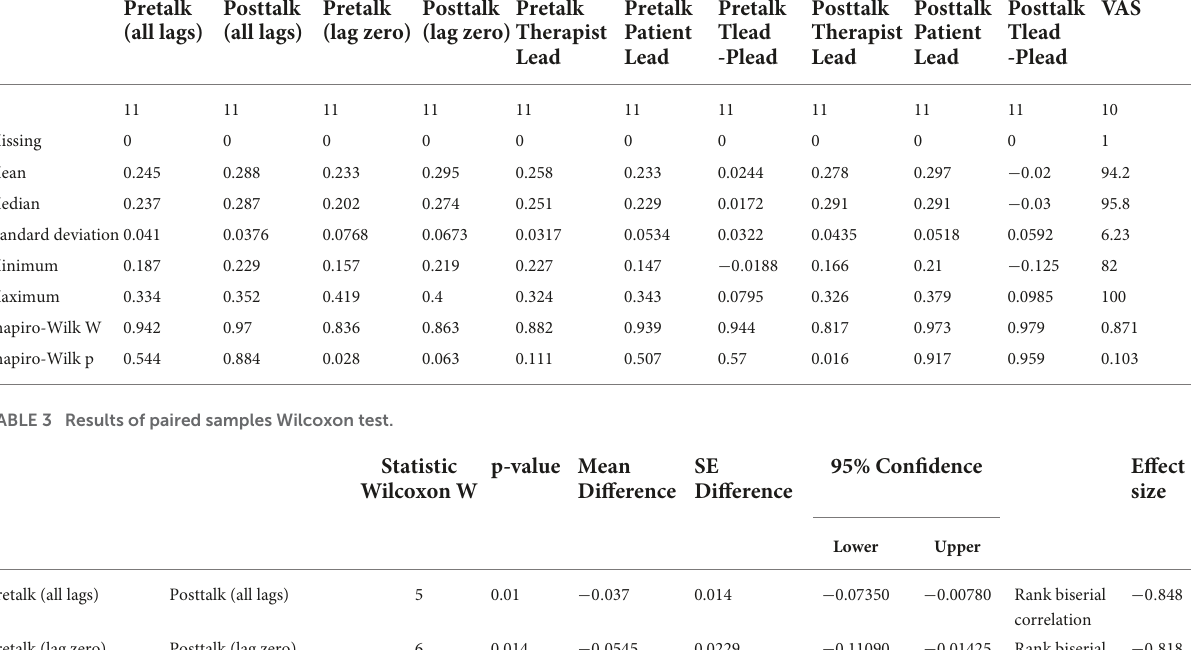
TABLE 2 Descriptive.